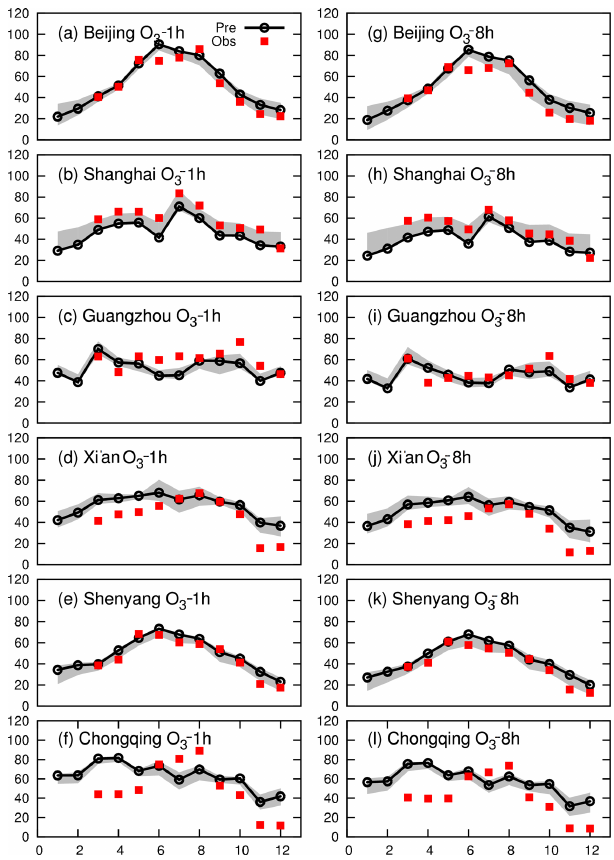
Figure 3. Comparison of predicted and observed O 3 -1h and O 3 -8h concentrations at Beijing, Shanghai, Guangzhou, Xi’an, Shenyang, and Chongqing. Grey areas represent ranges in model predictions within 3 × 3 grid cells surrounding the observation. Units